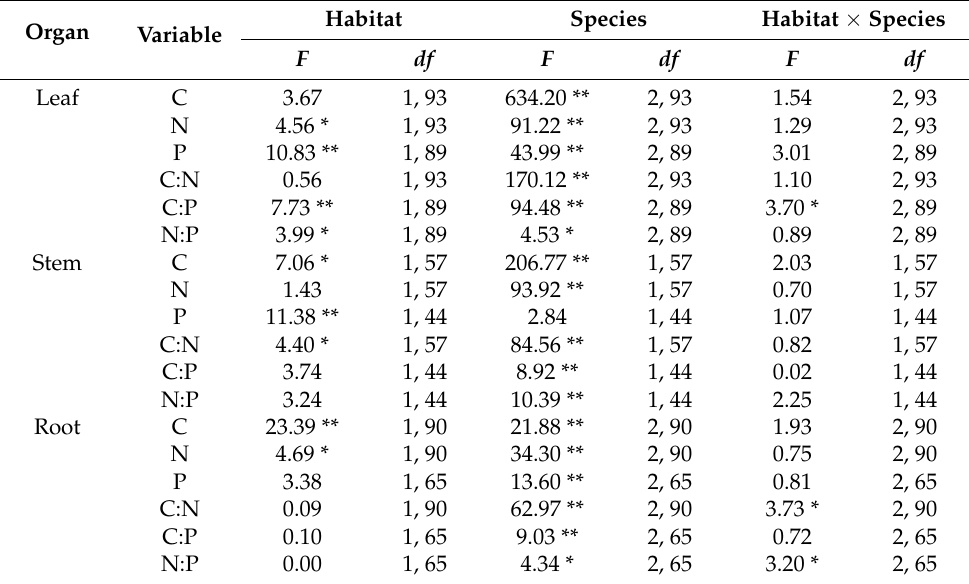
Table 2. Effects of species, habitats, and their interactions on stoichiometric traits of C, N, and P in different organs of facultative epiphytes in field experiment. Habitat Species Habitat × Organ Variable